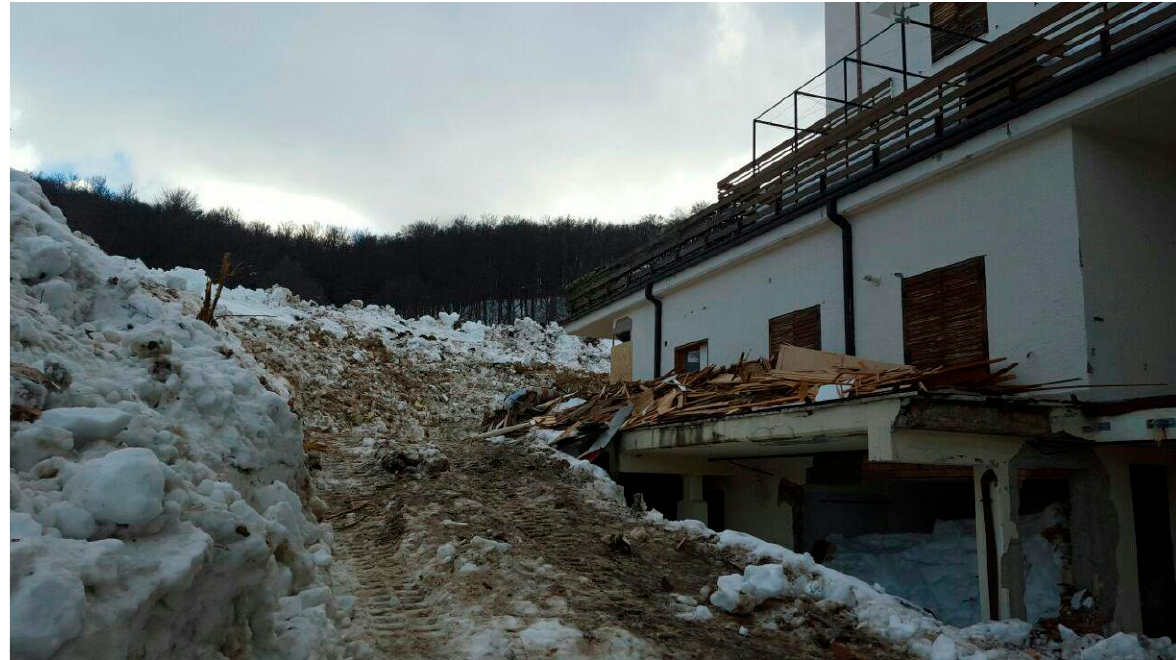
Figure 14. Detail of damage caused by the Vallone della Giumenta avalanche to the Prati di Tivo residence on 18 January 2017 (source Il Martino, 2017). For the avalanche path’s location, see Figure 12.